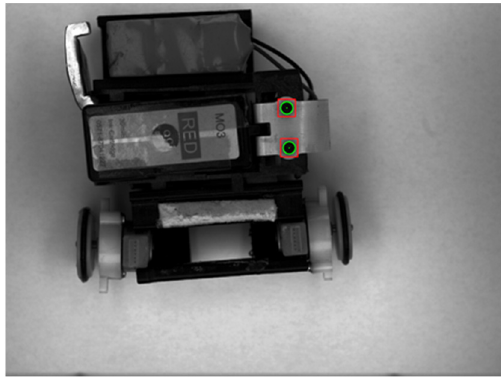
Figure 7. Circular tracking object.